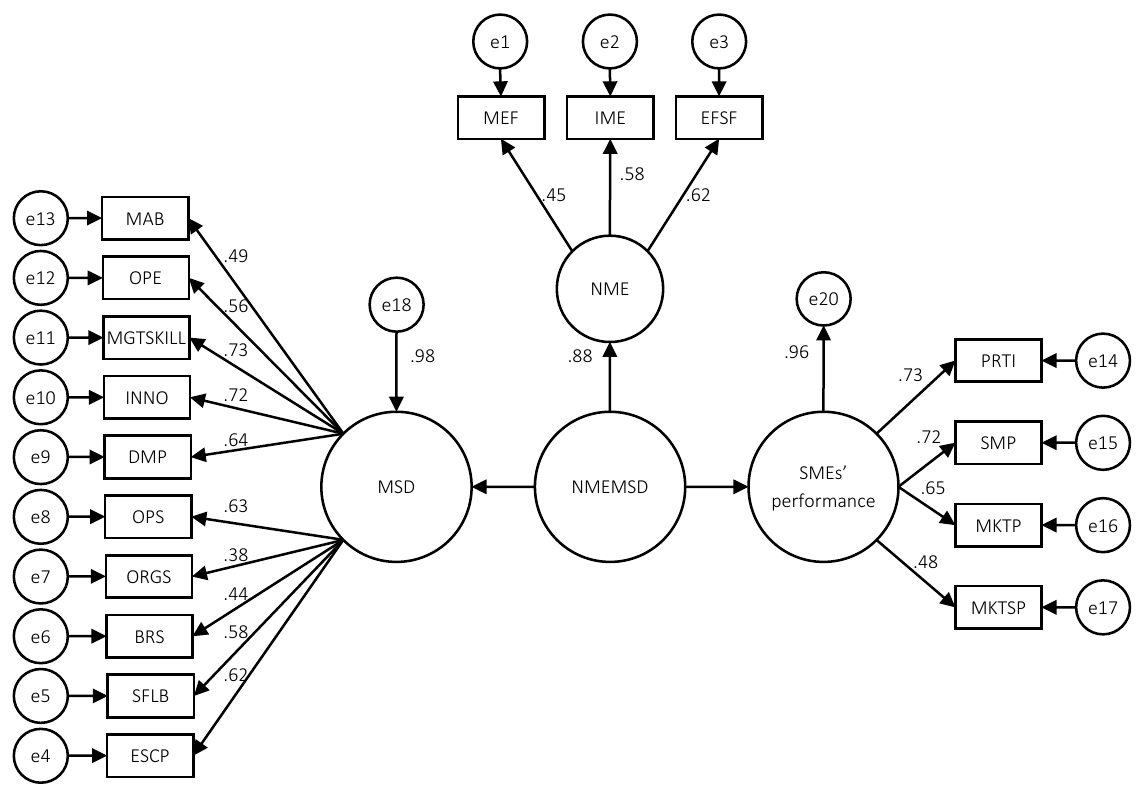
Figure 1. Path analysis diagram of the moderating effects of Nigerian market environment on the relationship between the management success factors and SMEs’